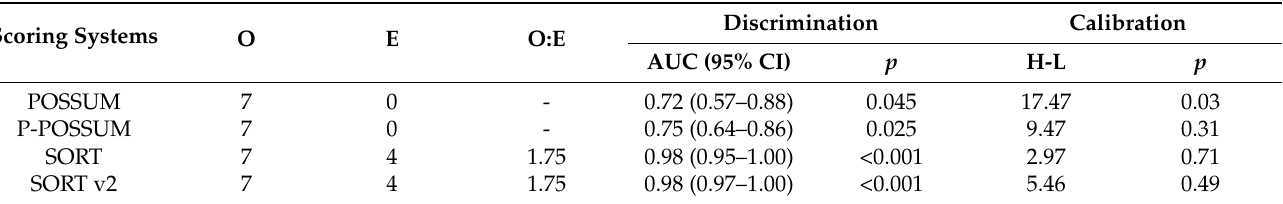
Table 2. Discrimination and calibration traits for each score regarding the prediction of mortality in patients with pancreatic cancer undergoing